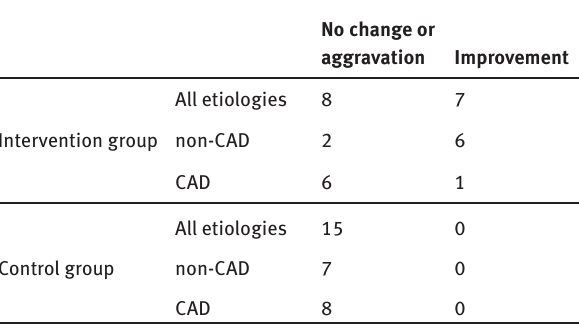
Table 2: A detailed breakdown of NYHA change before and after intervention in the intervention and control groups as a function of etiology.